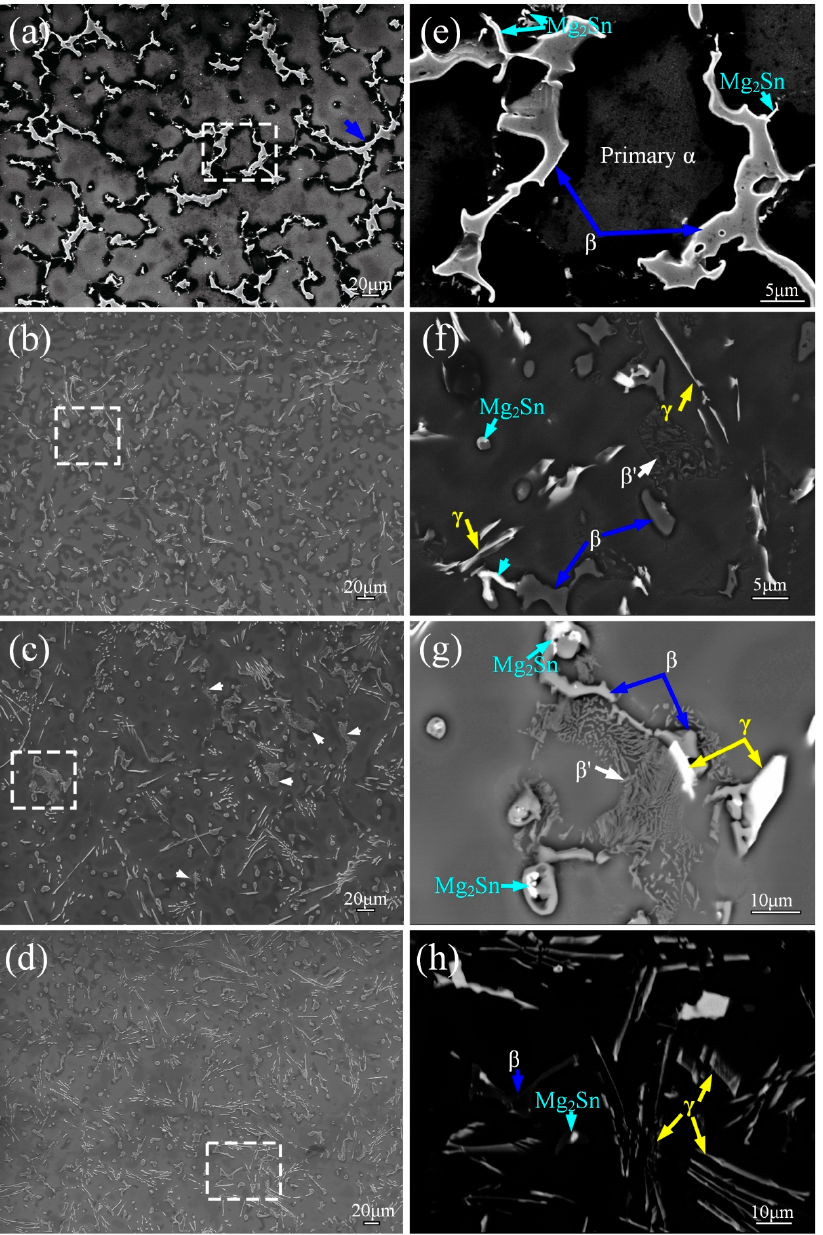
Figure 2. The typical SEM morphologies of as-cast samples for ( a , e ) ATZ731, ( b , f ) ATZE7310, ( b , c , f , g ) ATZE7311 and ( d , h ) ATZE7312. Note that ( e – h ) are the high magnification BSD of local ( a – d ) as pointed by the dotted line square respectively. β represents Mg 17 Al 12 phase, while γ is Al 4 Mm